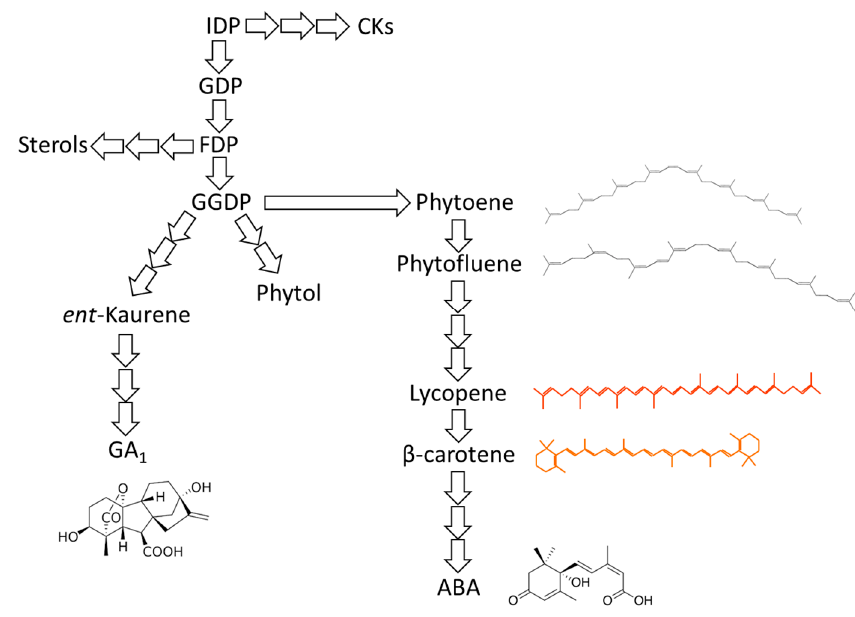
Figure 1. General scheme of pathways leading to production of different hormones. ABA and GAs share their biosynthetic pathway with other hormones, such as CKs. During fruit maturation, balance among hormone biosynthesis changes, and this involves carotenogenesis. IDP, isopentenyl diphos- phate; GDP, geranyl diphosphate; FDP, farnesyl diphosphate; GGDP, geranyilgeranyl diphosphate . Number of arrows illustrate number of biosynthetic